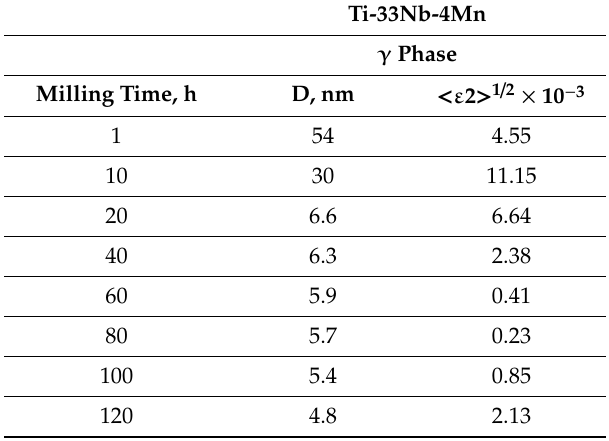
Table 3. Microstructural parameters as a function of milling time for the Ti-33Nb-4Mn alloy